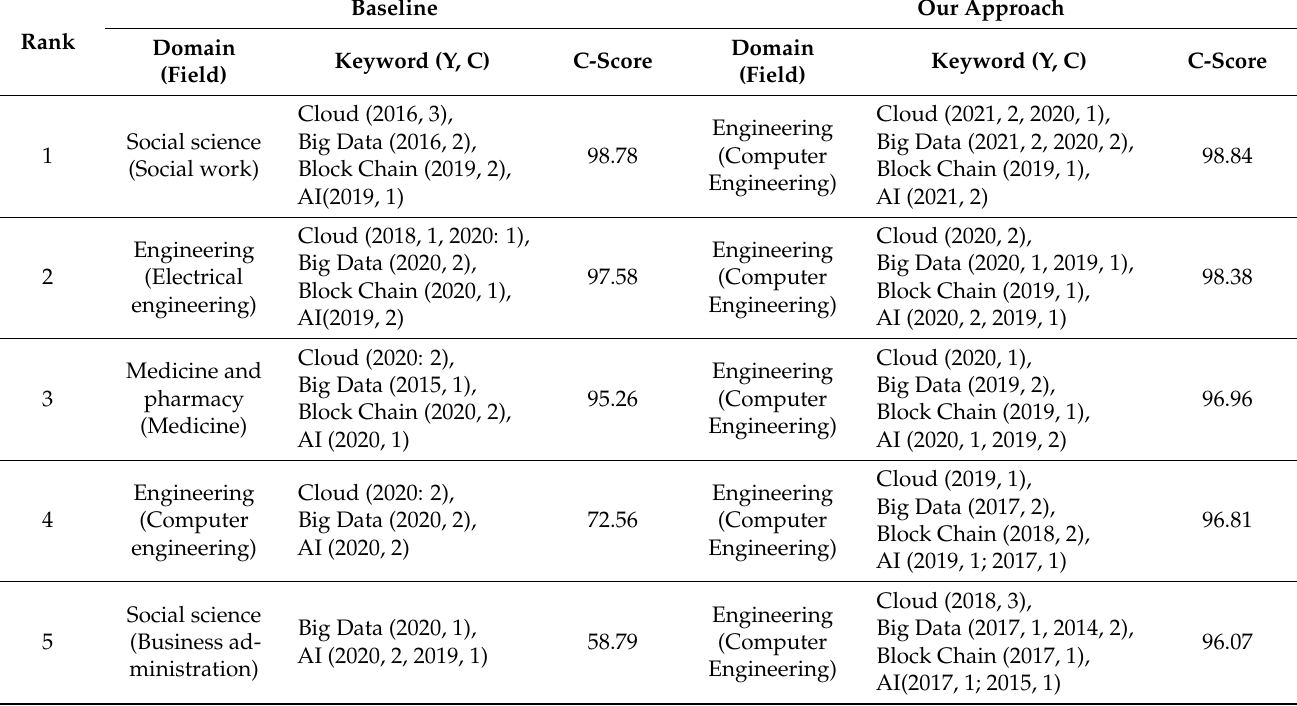
Table 5. Comparison of the baseline and our